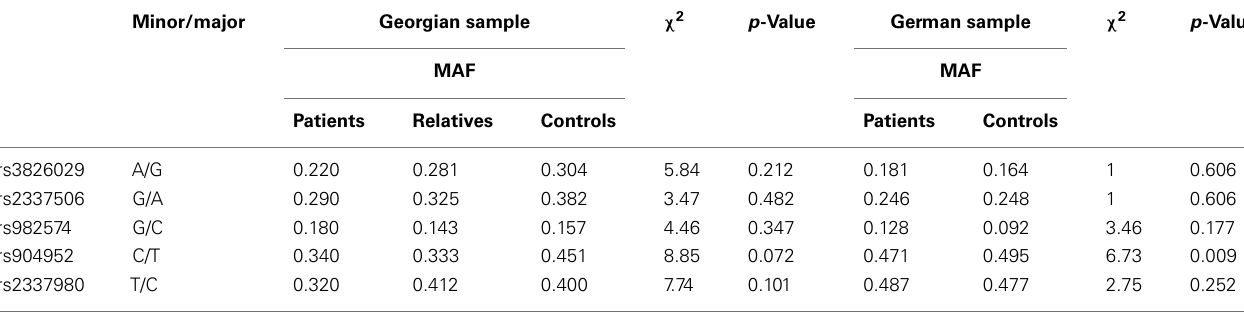
Table 6 |Association of CHRNA7 with diagnosis in German and Georgian samples.